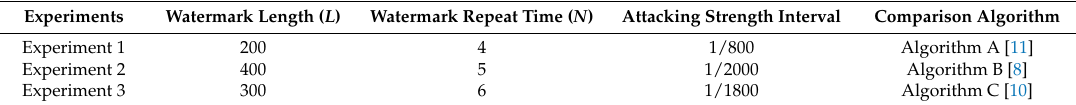
Table 1. Experimental parameters ( L = 200 and N = 4).